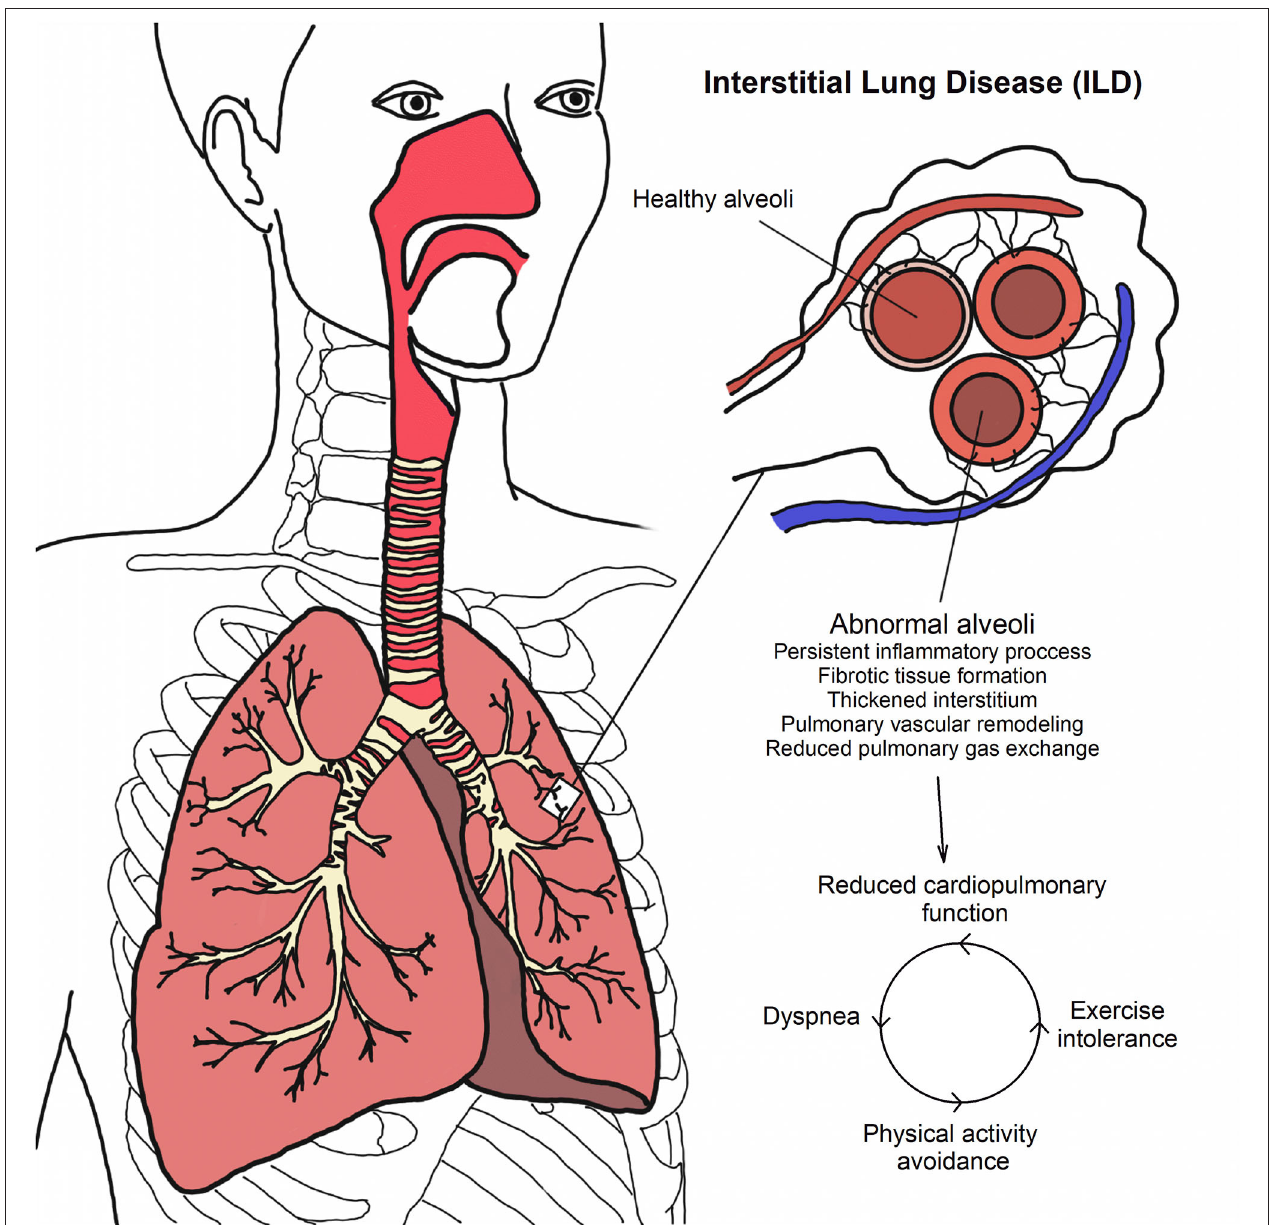
FIGURE 1 | Pathophysiology and cycle of reduced physical activity levels in